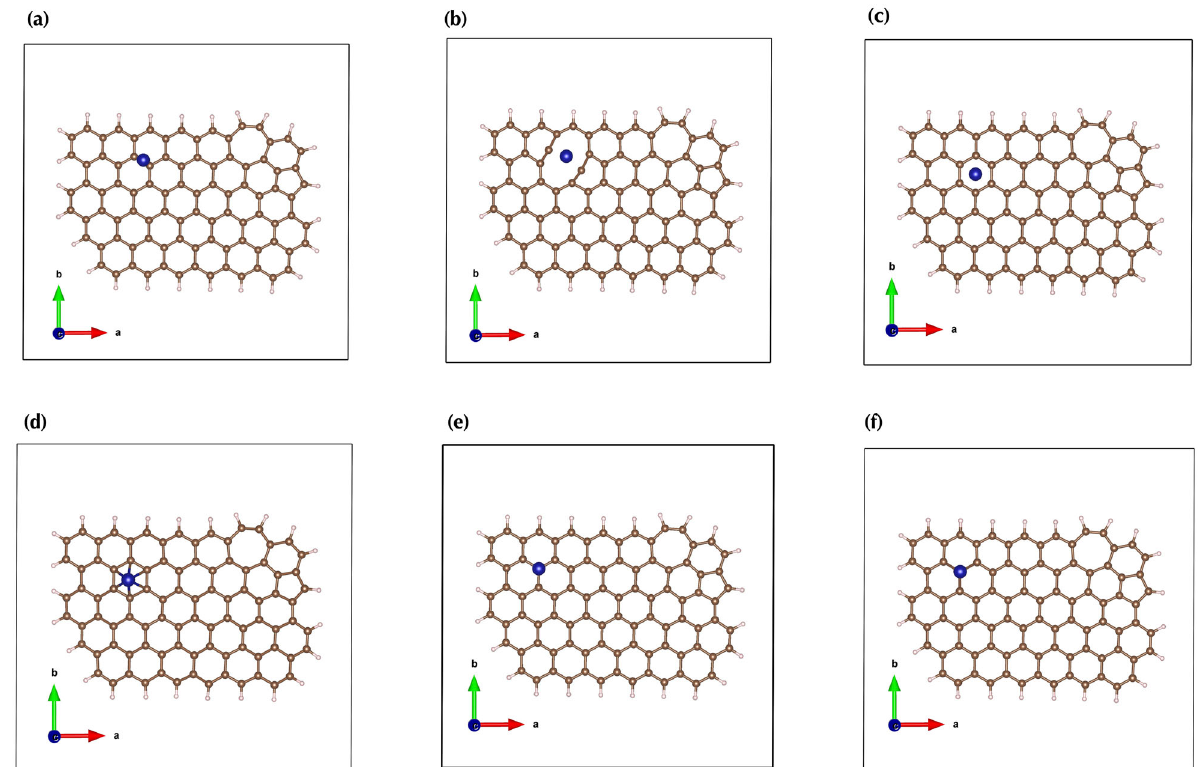
Fig. 5 Snapshots from AIMD simulations with Cr ad-atom performed at 300 K. Initial con fi gurations where Cr atom is added to the bridge ( a ), hollow ( c ), and top ( e ) sites and dynamics is studied at 300 K. The positions after 10 fs ( b ), 14 fs ( d ), and 2000 fs ( f ) are shown in the fi gure.